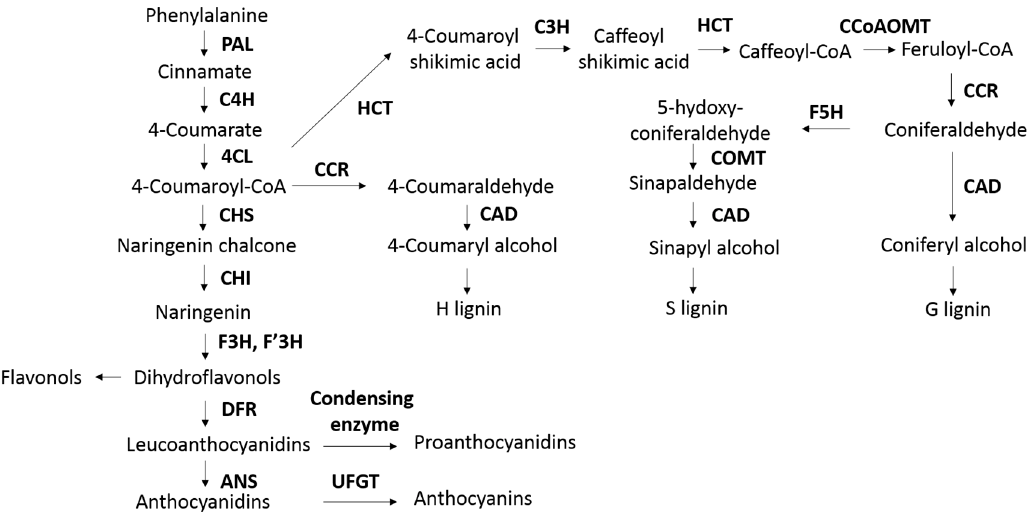
Figure 1. Biosynthesis of proanthocyanidins/anthocyanins and lignin monolognols. This figure was made based on information from Zabala et al. [25], Nesi et al. [29], Vanholme et al. [30] and Jonker [13]. PAL, L -phenylalanine ammonia-lyase; C4H, cinnamate 4-hydroxylase; 4CL, 4-coumarate coenzyme A ligase; CCR, cinnamoyl coenzyme A reductase; CAD, cinnamyl alcohol dehydrogenase; HCT, hydroxycinnamoyl-CoA: shikimate/quinate hydroxycinnamoyltransferase; C3H, coumarate 3-hydroxylase; CCoAOMT, caffeoyl CoA 3- O -methyltransferase; F5H, ferulate 5-hydroxylase; COMT, caffeic acid 3- O -methyltransferase; CHS, chalcone synthase; CHI, chalcone isomerase; F3H, flavanone 3-hydroxylase; DFR, dihydroflavanol 4-reductase; ANS, anthocyanidin synthase; UFGT, UDP-flavonoid glucosyltransferase. H lignin, hydroxyphenyl; S lignin, syringyl; G lignin, guaiacyl.